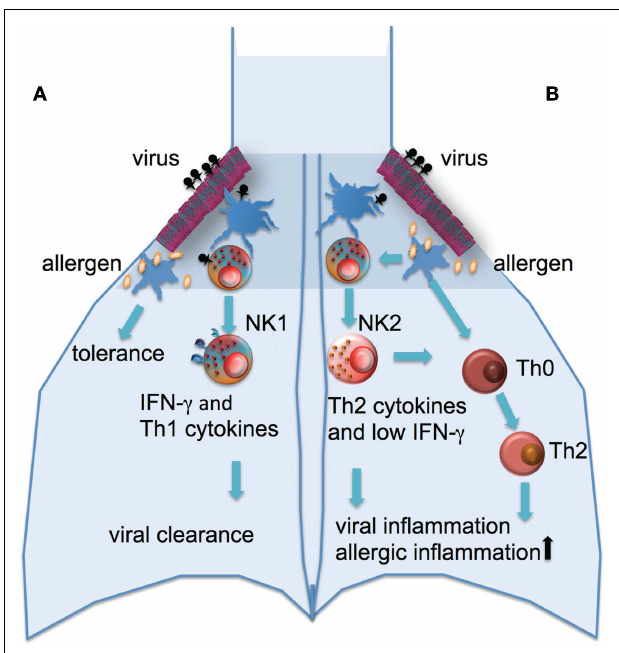
FIGURE 1 | Potential role of NK cells in the development of allergic airway disease . (A) A robust NK cell response to respiratory viral infection with high levels of IFN γ production and cytolytic activity this leads to viral clearance andTh1 environment in the lung and normal tolerance to environmental antigens. (B) An impaired response to viral infection with low IFN γ and cytolytic activity and higher levels ofTh2-type cytokines released from NK cells leads to increased inflammation and viral shedding, the recruitment of immature DCs, allergic sensitization with subsequent